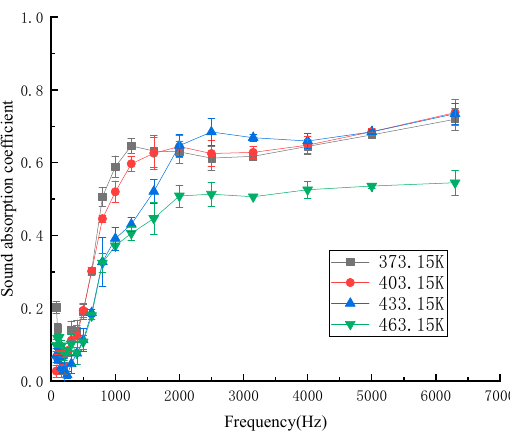
Figure 3. Sound-absorption coefficient at different hot pressing temperatures.